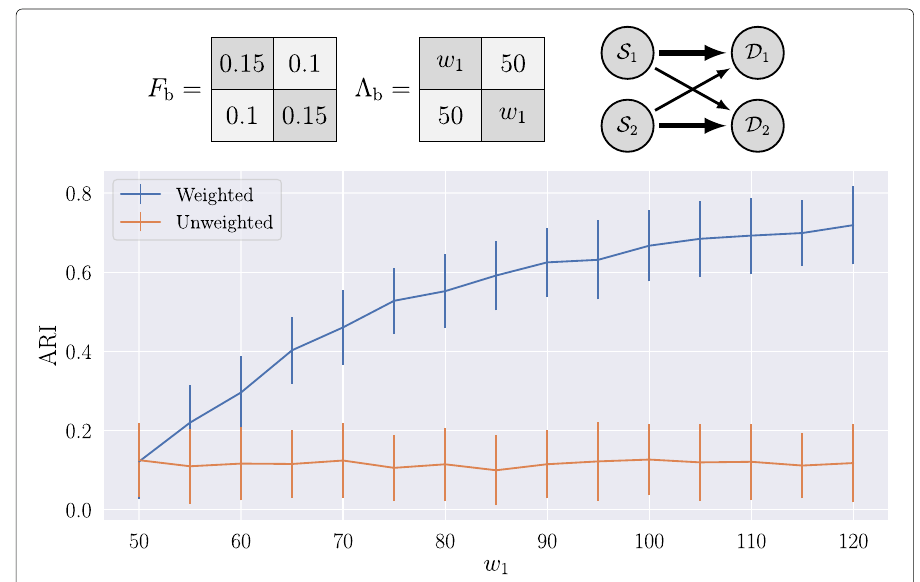
Fig. 8 Top: BSBM parameters for Example 3 Experiment 1. Left panel is the connection matrix, middle panel is the weight matrix (see Eq. 6 and Section 4.2 for details), and right panel is a schematic diagram of the structure. Bottom: performance of our bipartite collider method with and without edge weights. We perform 100 repeats, and error bars are one sample standard